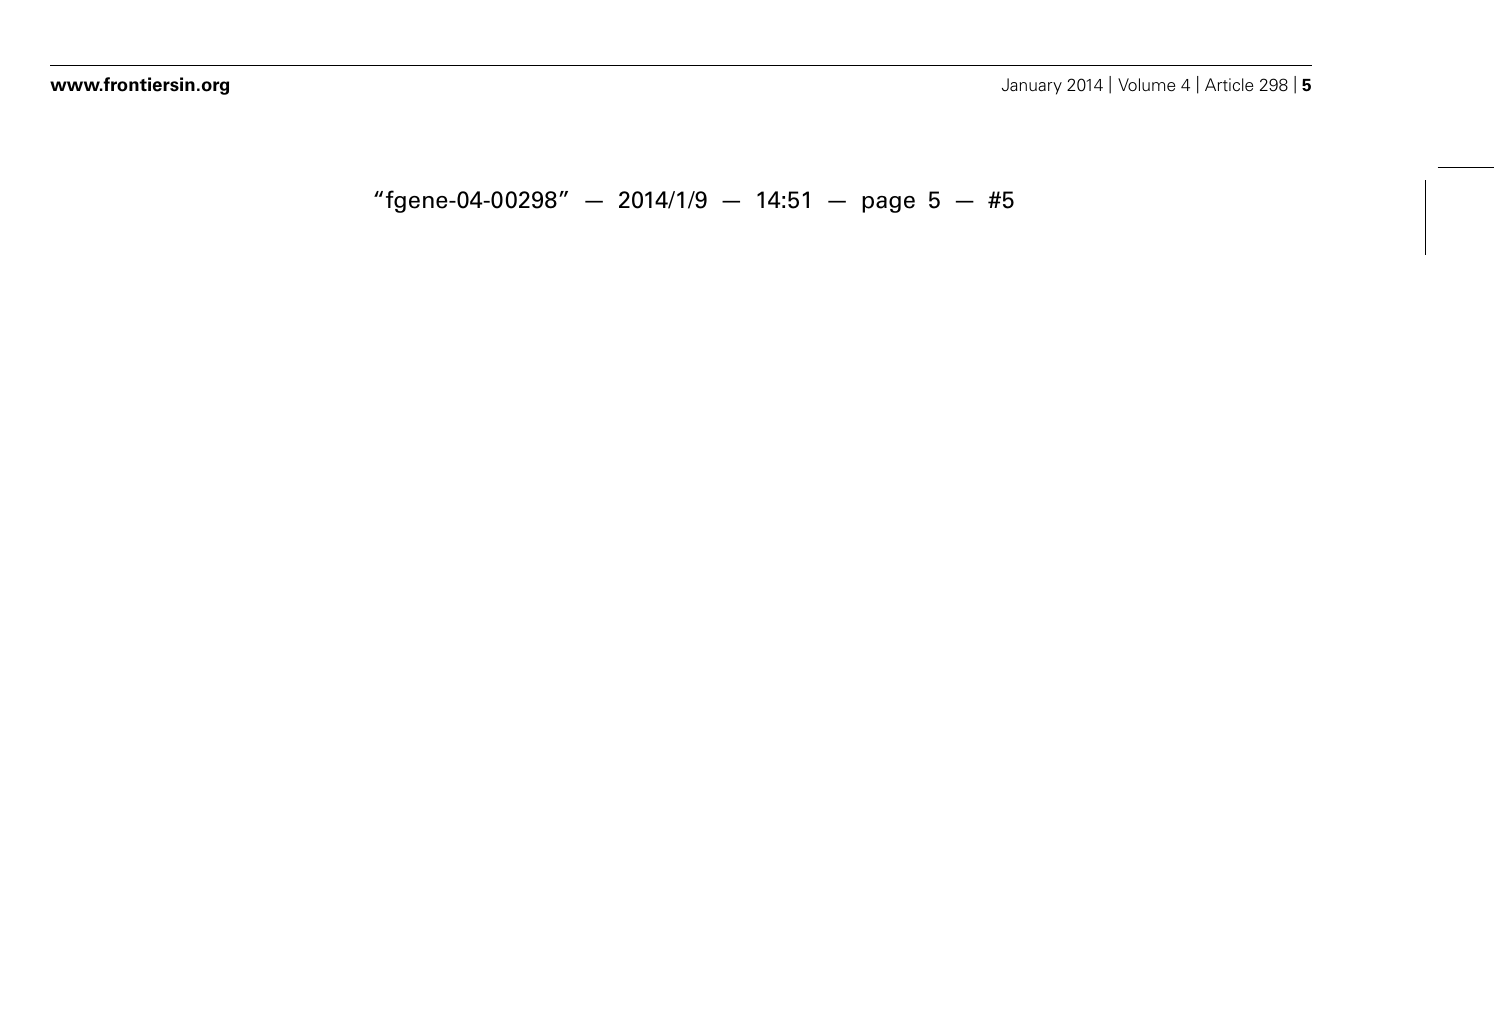
FIGURE 3 | Magnetic resonance angiography of a brain tumor to evaluate the tortuosity of the vascular network. Vessels within the tumor nidus are shown in red, vessels supplying or passing through the nidus in gold, while normal vessels outside the nidus are blue. The